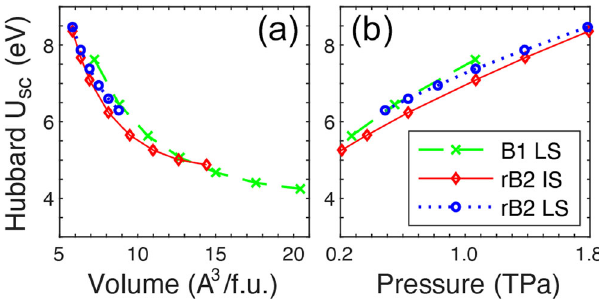
Fig. 2 Self-consistent Hubbard U ( U sc ) of Fe at ultrahigh pressure. a U sc of intermediate-spin (IS) and low-spin (LS) Fe in B1 and rB2 (Mg 0.875 Fe 0.125 )O at various volumes. b U sc plotted with respect to pressure in the region of 0.2 – 1.8